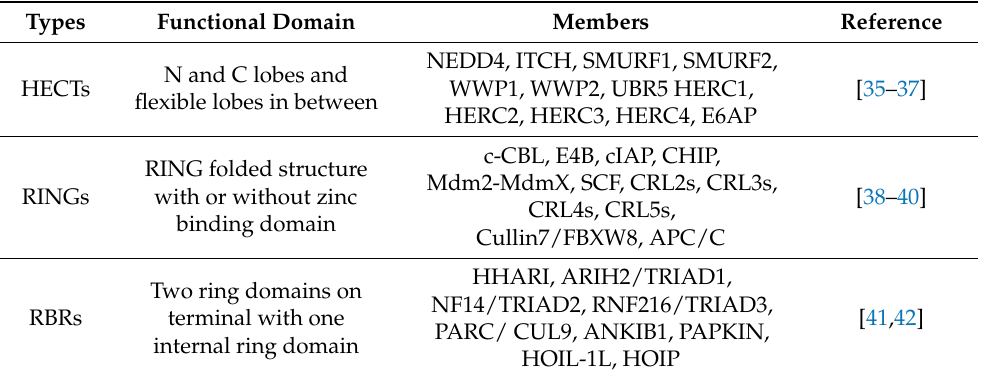
Table 1. Characteristics of E3 ubiquitin ligase